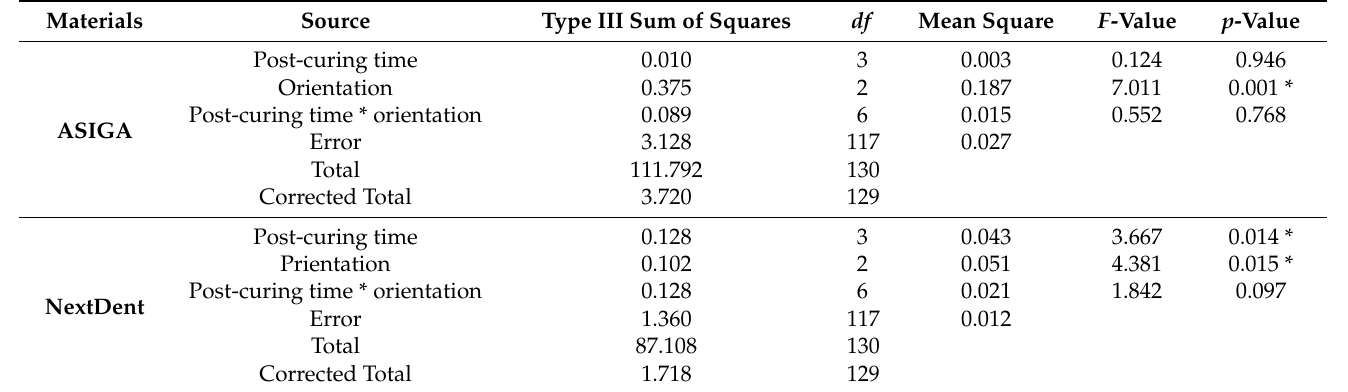
Table 2. Two-way ANOVA for combine effect of orientation and post-curing time on the surface roughness of each material.